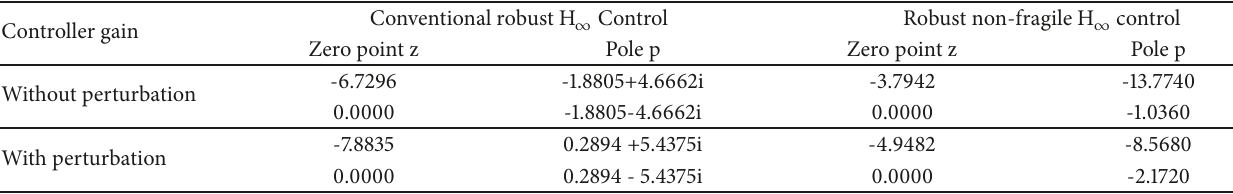
Table 4: Vehicle body head-shaking acceleration zero pole value.